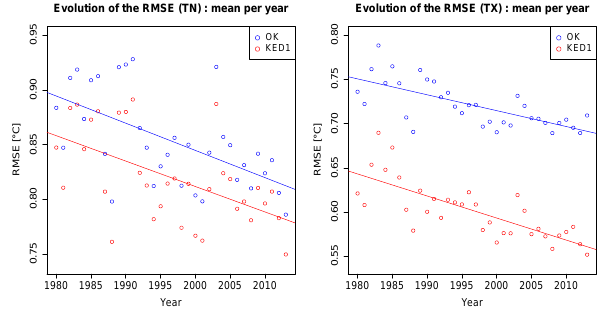
Figure 6. Evolution of the averaged annual RMSE cv and regression line using ordinary kriging (OK) and kriging with external drift us- ing orography (KED 1 ) for TN (left panel) and TX (right panel).